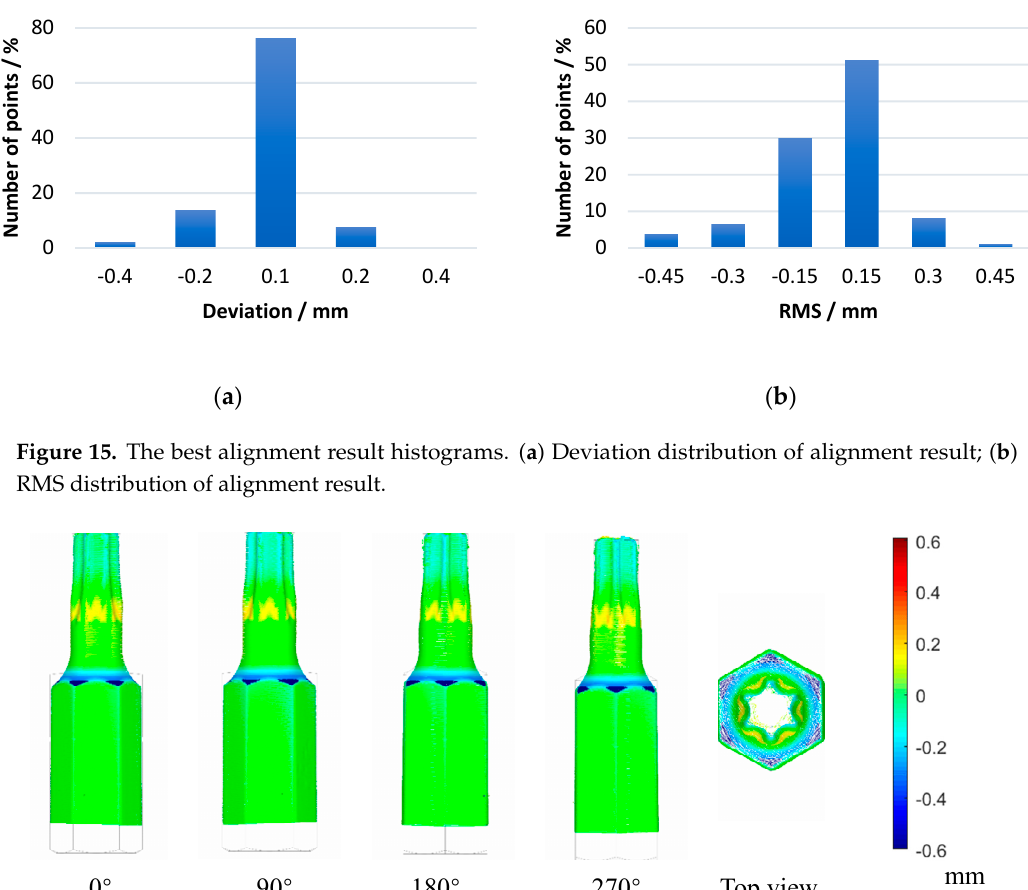
Figure 16. 3D deviation distribution on multi-view workpiece surface. Table 6. The statistical results of the two methods.